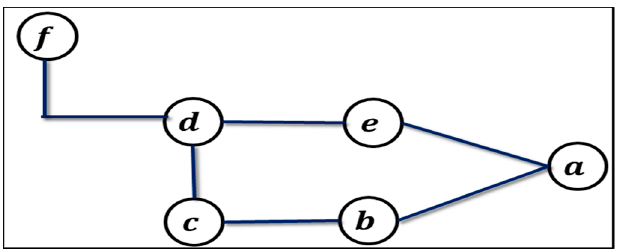
Figure 8. Vertex set V = { b, d, e } covers all nodes in graph G.